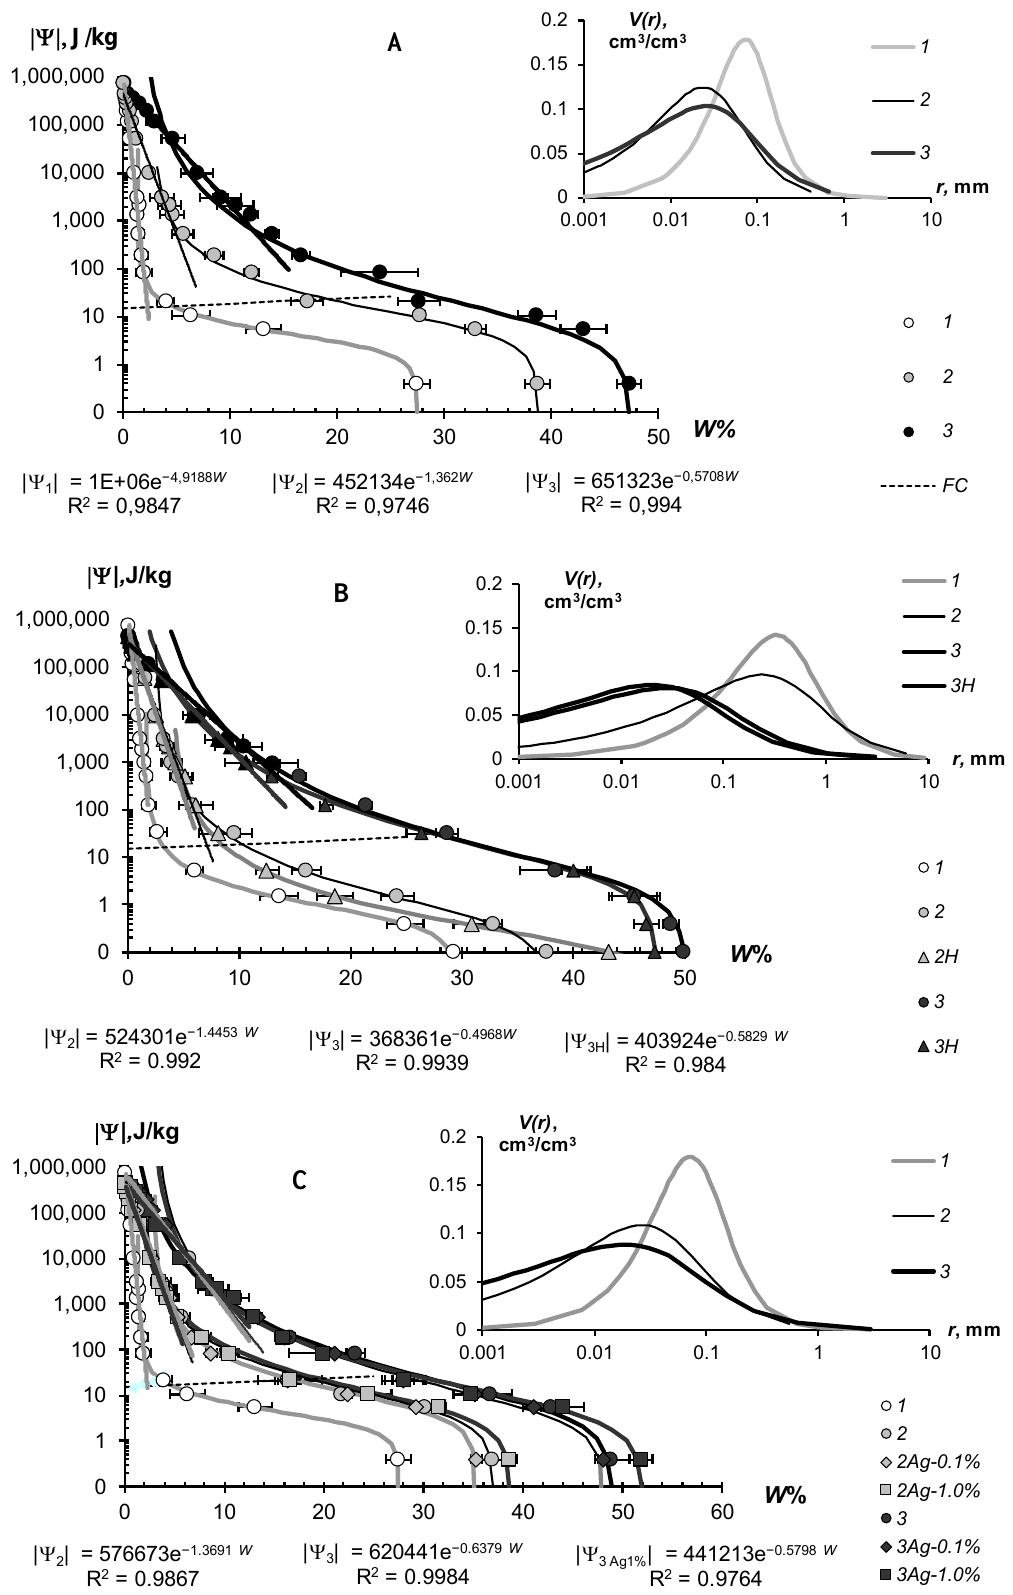
| | = 620441e − 0.6379 W 3 R 2 = 0.9984 Figure 7. WRC of soil-gel composition (main figure) and pore distribution curves (inset) in monomineral quartz sand. ( A ) — Aquasorb; ( B ) — A11; ( C ) — A22; 1 — untreated control; 2 — 0.1% gel dose; 3 — 0.3% gel dose; H — humates; Ag 0.1%, Ag 1% are silver doses of 0.1 and 1%.